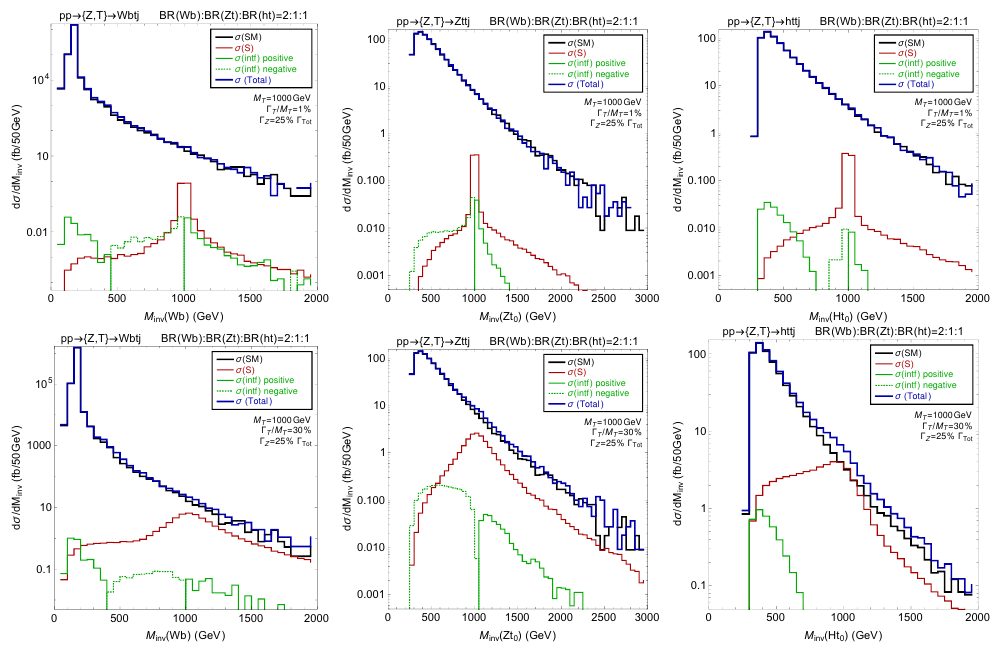
Figure 22 . Parton-level distributions in the invariant mass of the Wb (left), Zt (centre) and ht (right) systems for the pp → Wbtj , pp → Zttj and pp → httj processes respectively. We include the SM contribution (black), the new physics contributions stemming from a vector-like quark of mass M = 1 TeV (red) and the absolute value of their interference (green). We indicate by a T dashed line the region in which the interference is negative. We consider a narrow width scenario ( Γ = 1% , top row) and a large width one ( Γ = 30% , bottom row), and the T couplings T /M T T /M T are fixed as in eq. (3.7).